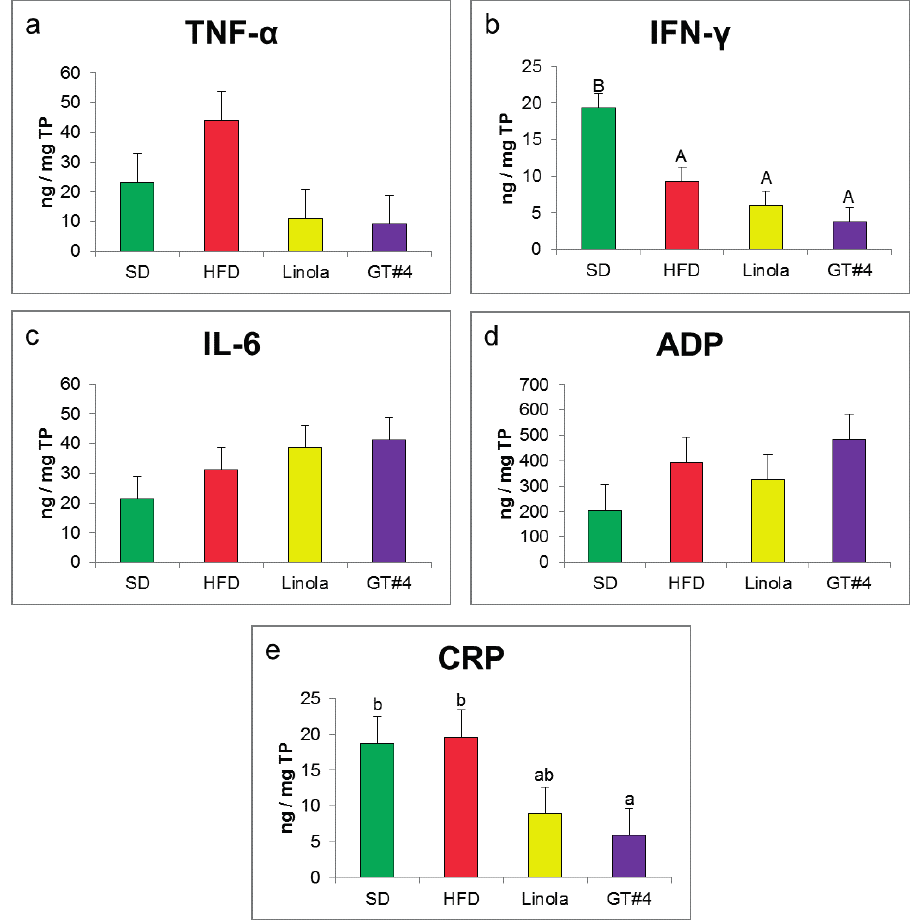
Figure 4. The influence of feeding with experimental diets on the level of pro- and anti-inflammatory state markers in mice liver. ( a ) TNF- α ( b ) IFN- γ ( c ) IL-6 ( d ) ADP and ( e ) CRP. The error bars indicate the SEM. Significant effect: values that do not share a common small letter (a,b) differ significantly at the level p < 0.05, and values that do not share a common capital letter (A,B) differ significantly at the level p <